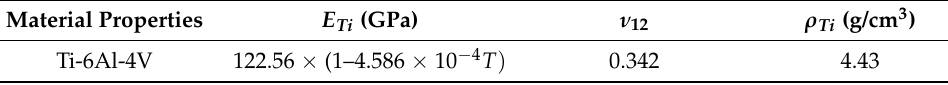
Figure 4. The structure of the auxetic honeycomb core. Table 4. The material properties of